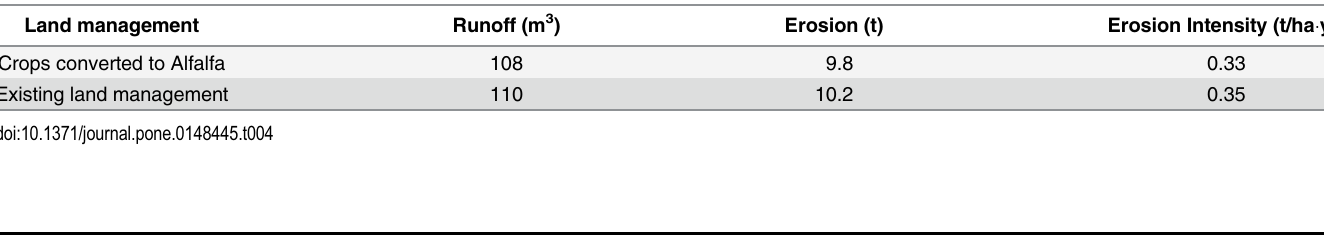
Table 4. Comparison between the measured and simulated